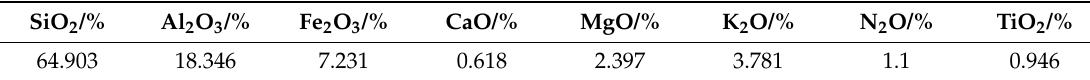
Table 2. The chemical composition of